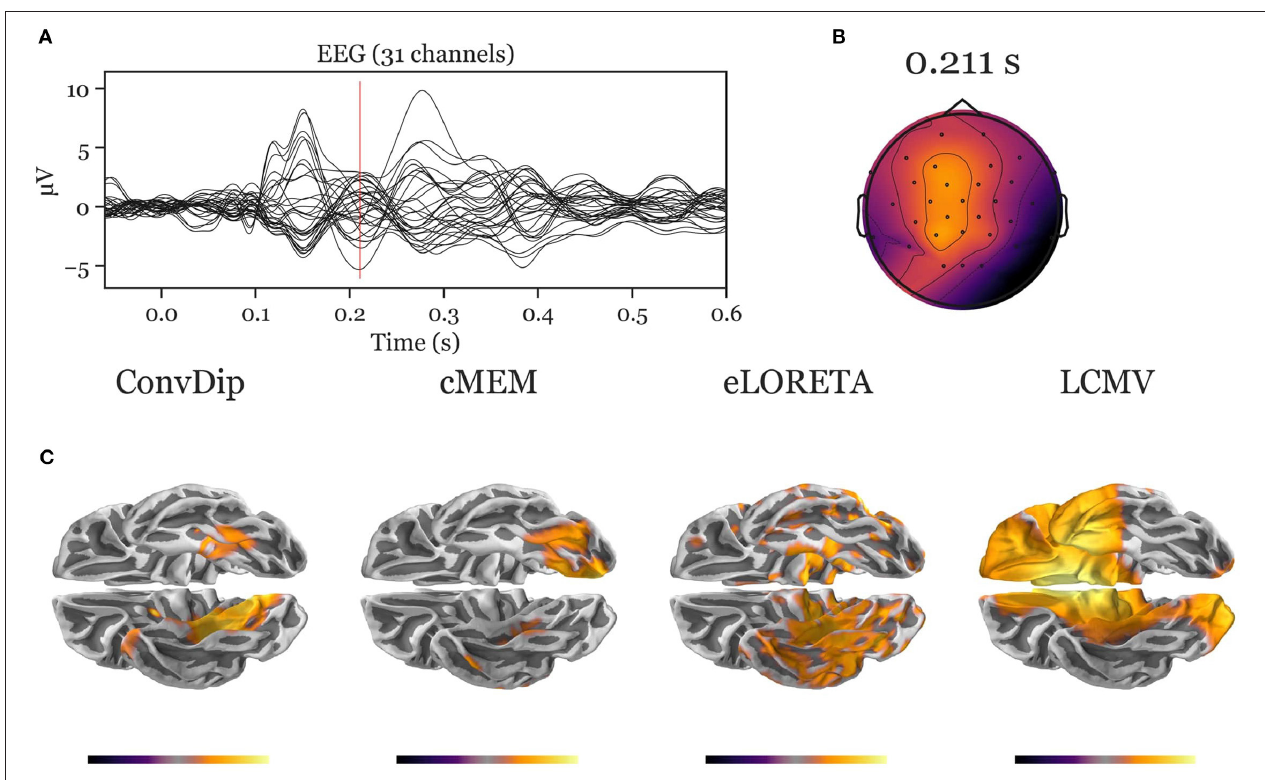
FIGURE A3 | Inverse solution of real face-evoked data. All inverse algorithms were subjected to real EEG data recorded from a single participant containing 150 trials of face-evoked potentials. (A) The ERP at each of the 31 channels. (B) The scalp map at a N170-like component (vertical red line in A, 211 ms after stimulus onset). (C) The dipole moments plotted on the white matter surface of the template brain in ventral view of the right hemisphere to reveal the inferior temporal cortex (ITC). Various inverse solutions show activity in the ITC. Notably, ConvDip and cMEM recover a focal source cluster close or within the fusiform face area, a region known to be involved in face processing (e.g., Kanwisher and Yovel, 2006; Joos et al., 2020). Voxels below 25% of the respective maximum are omitted for a clearer representation of the current